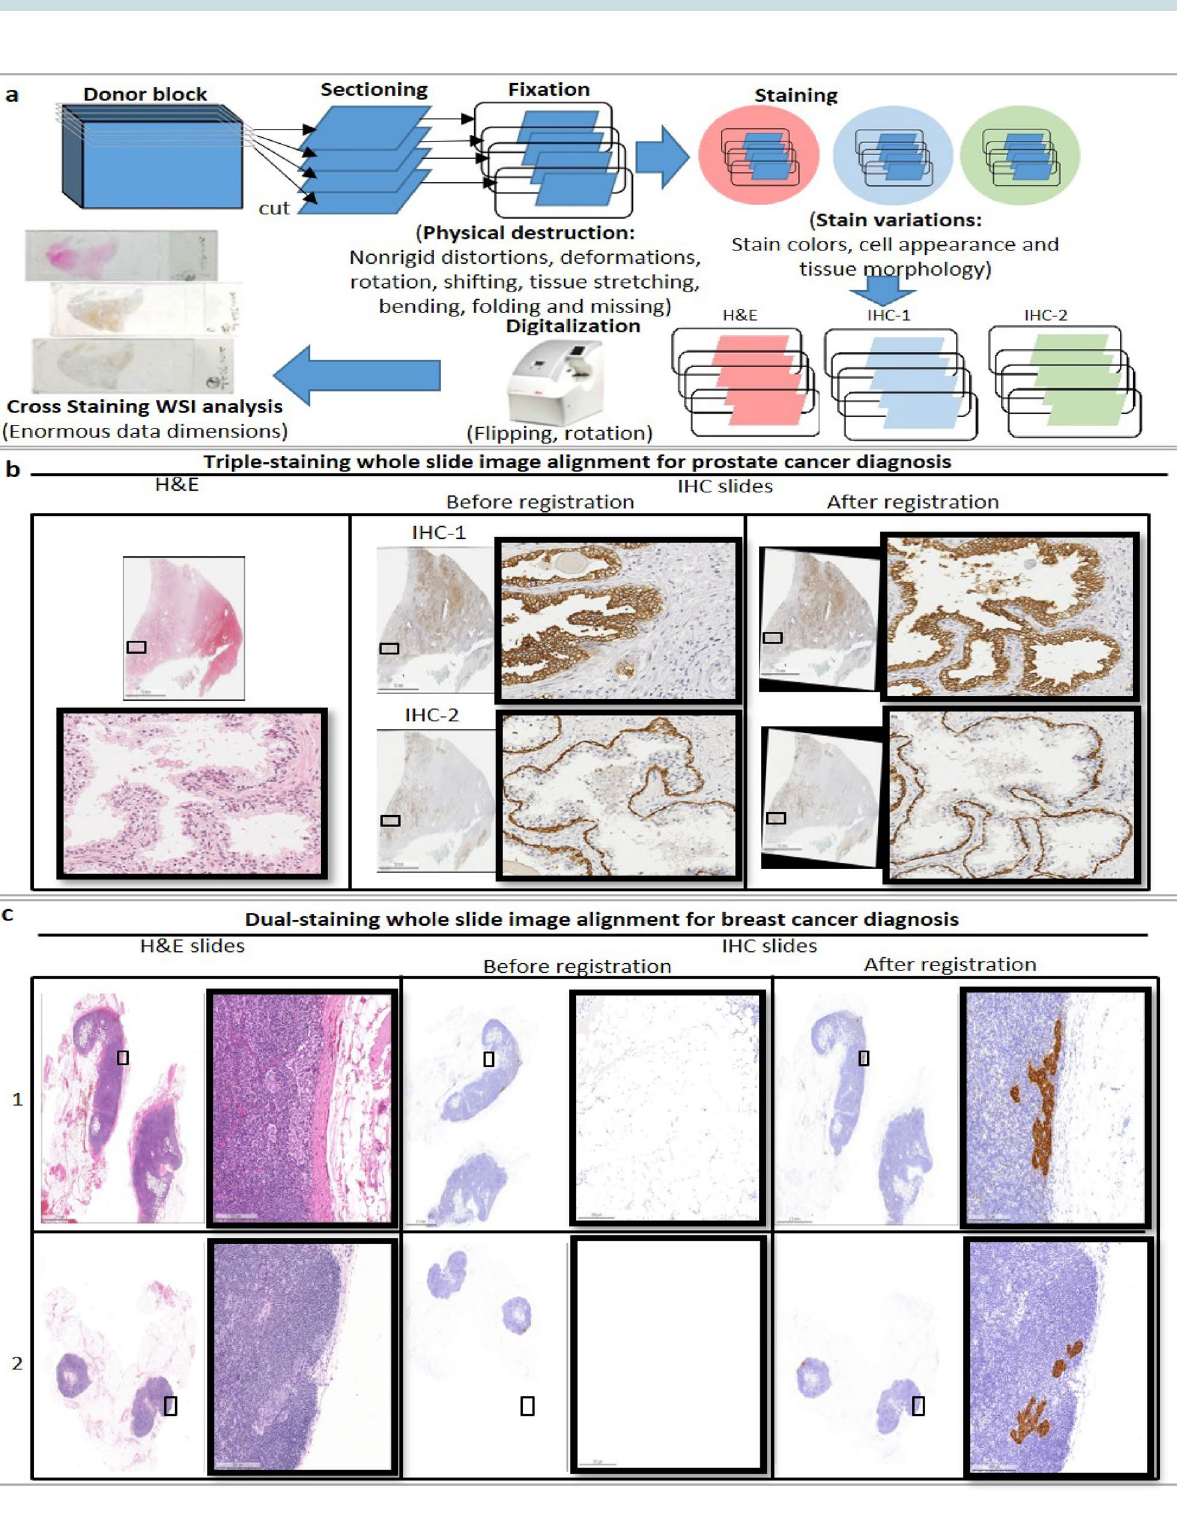
Figure 1. ( a ) Challenges caused by individual data preparation steps for cross staining WSI analysis. Sample results by the proposed method in ( b ) triple-staining WSI alignment of H&E, HMCK and CK18 slides for prostate cancer diagnosis and in ( c ) dual-staining WSI alignment of H&E and CK(AE1/AE3) slides for breast cancer